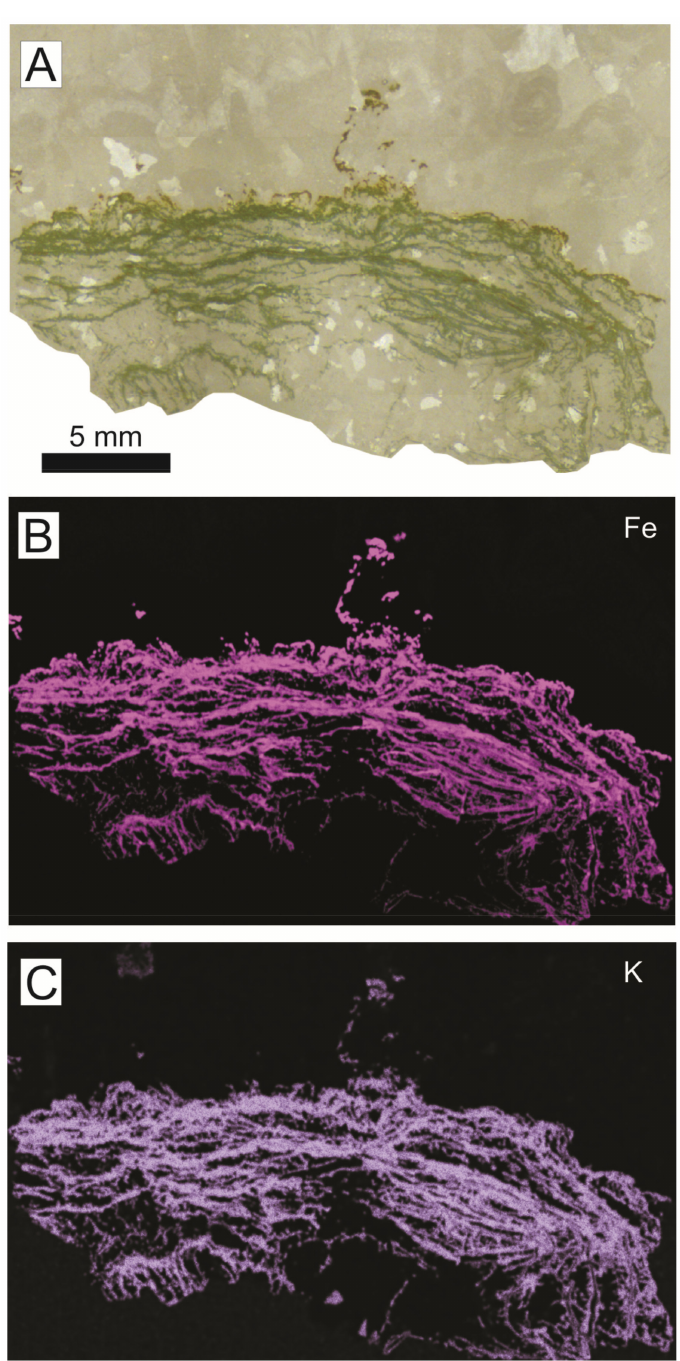
Figure 20. Original aspect ( A ) and elemental maps of XR-microfluorescence for Fe ( B ) and K ( C ) that illustrate the concentration of these elements in the green crust composed by glauconitic